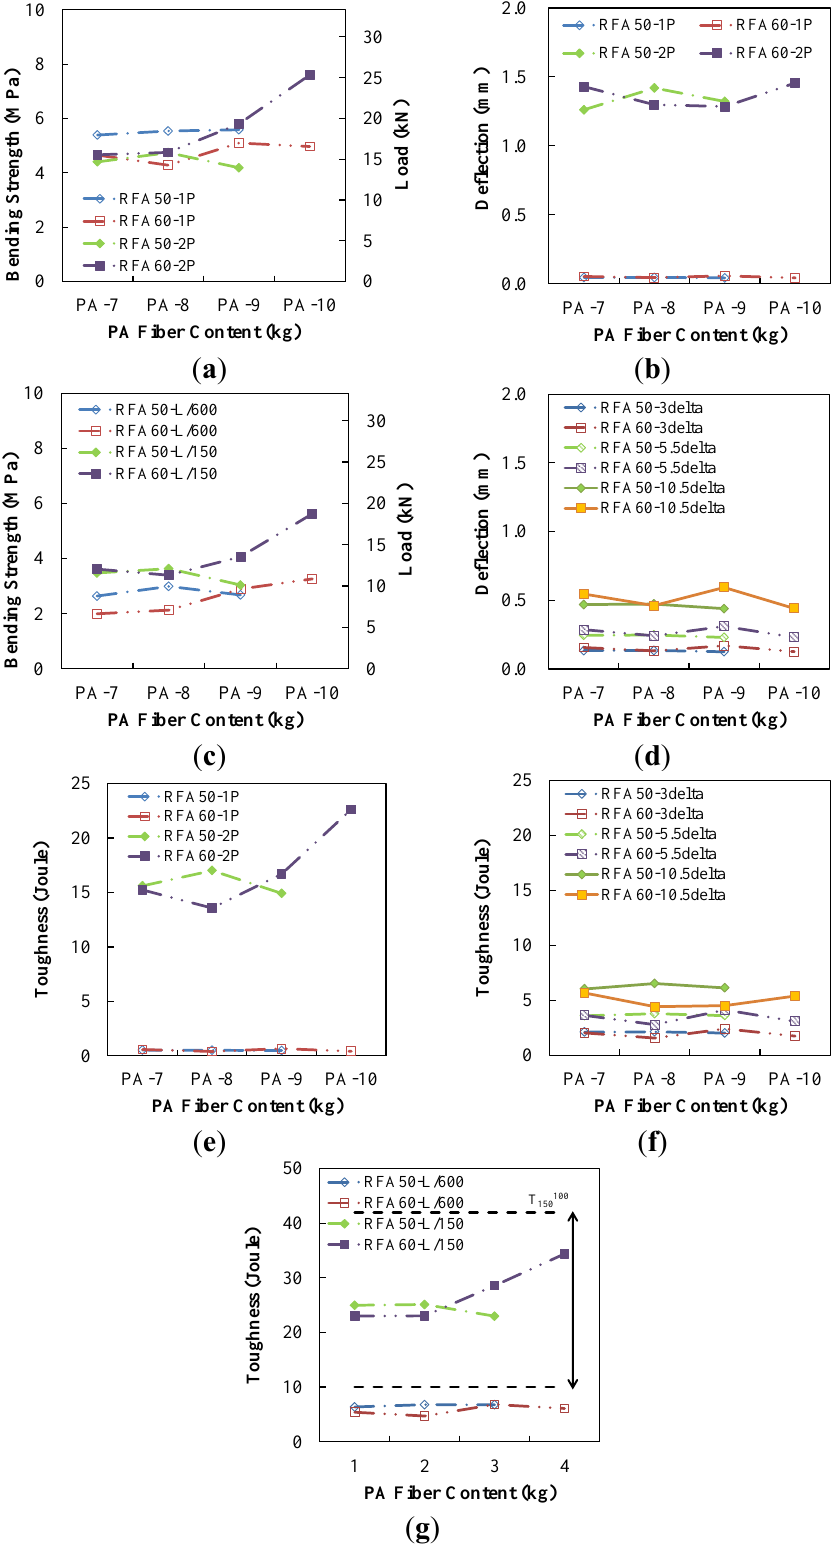
Figure 10. Average flexural responses of PAFRC. ( a ) Strength for first- and second-peak; ( b ) deflection for first- and second- peak; ( c ) strength for L/ 600 and L/ 150; ( d ) deflection for 3δ 1 , 5.5δ 1 and 10.5δ 1 ; ( e ) toughness for first- and second-peak; ( f ) toughness for 3δ 1 , 5.5δ 1 and 10.5δ 1 ; ( g )